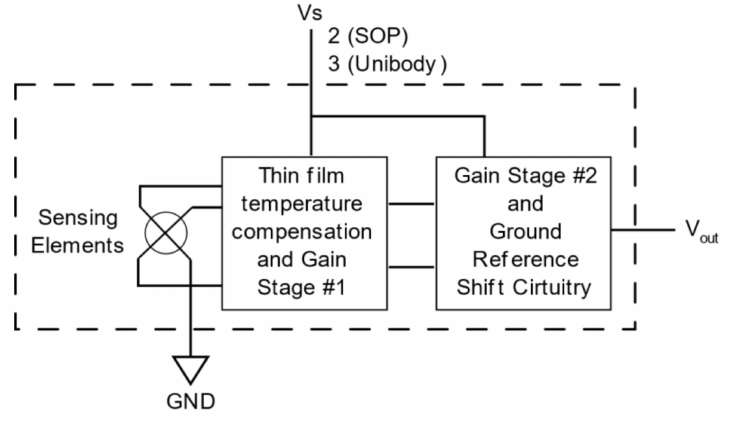
Figure 4. Pressure sensor schematic.